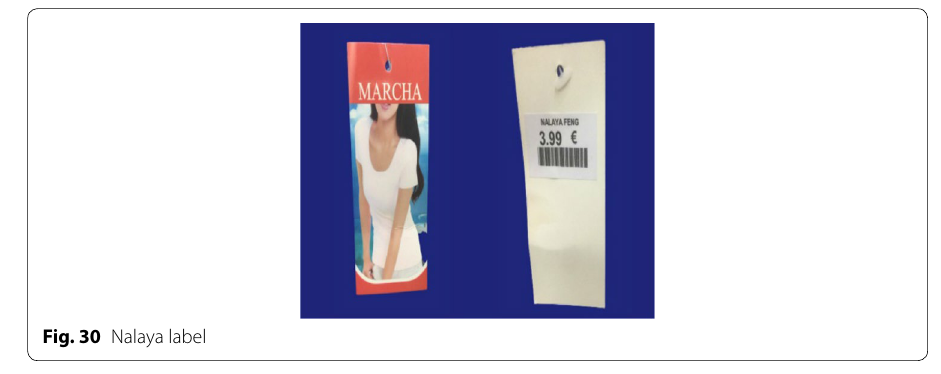
Fig. 29 Mi Vestidor label